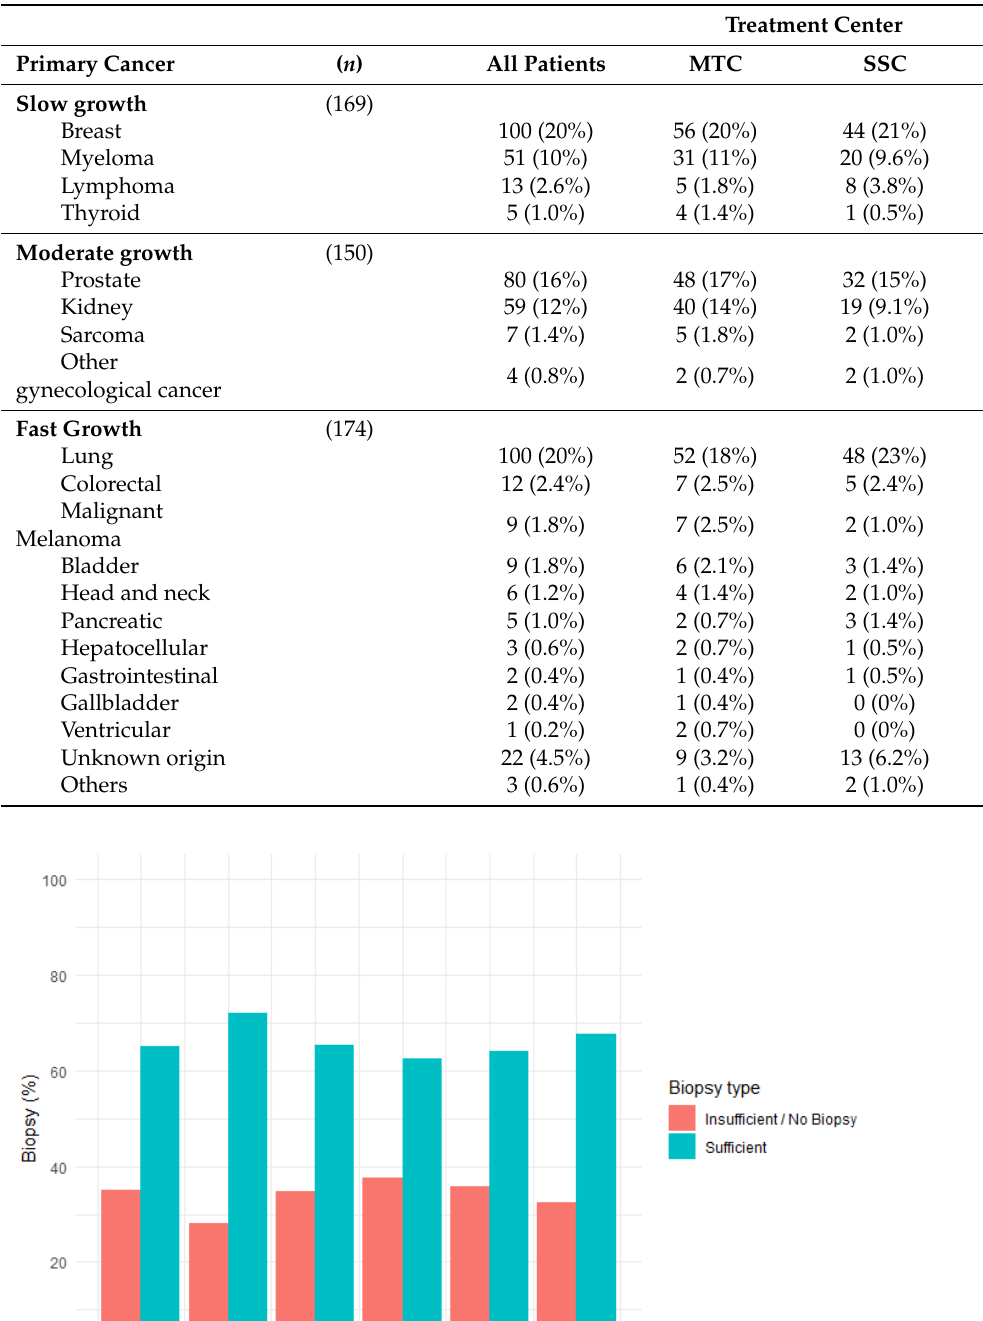
Table 2. Table describing subtypes of cancer divided in subgroups as described in Katagiri et al. [21] and further modification by Sørensen et al. [22].